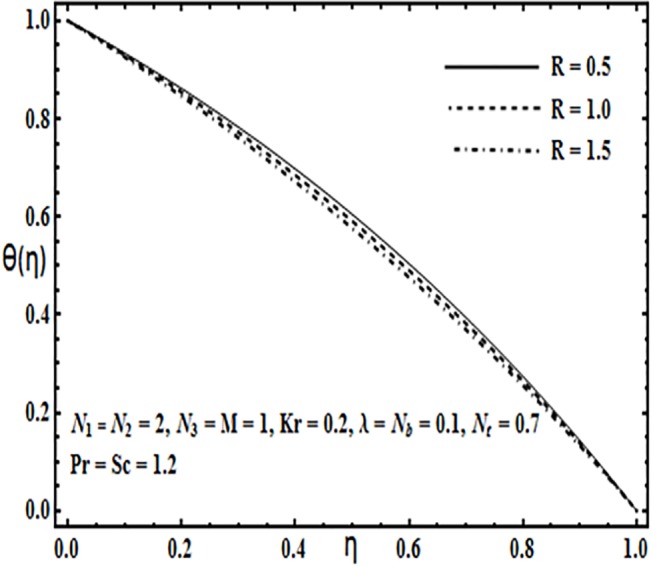
Effect of R on θ(η).